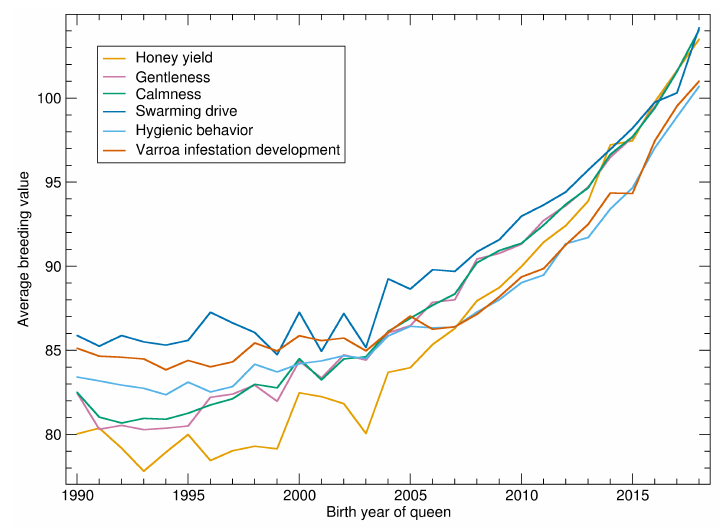
Figure 2. Yearly averages of normalized breeding values for all tested queens.